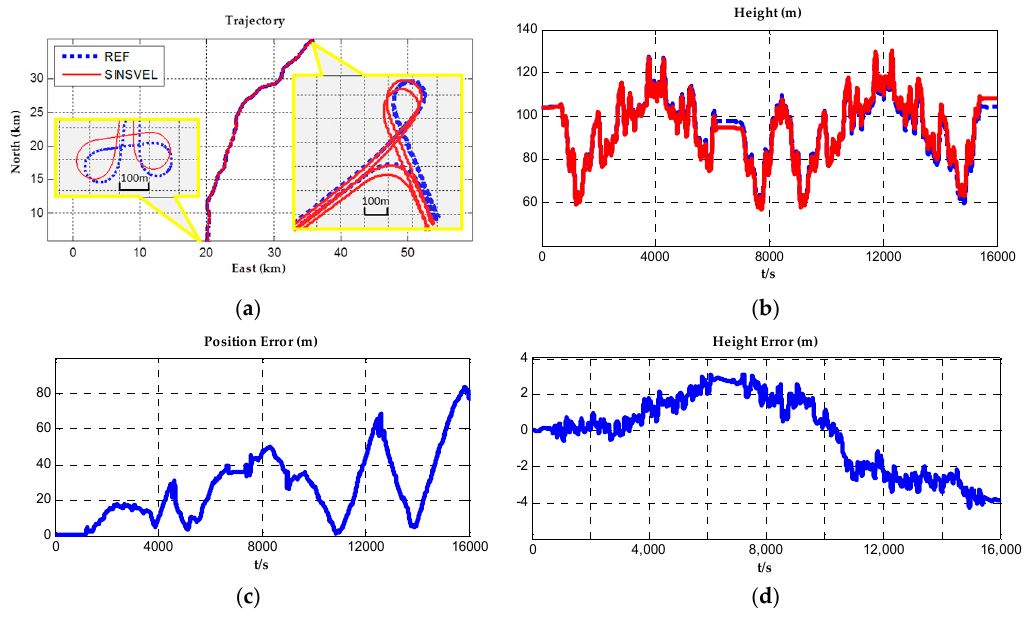
Figure 3. Position and error plots of SINS/VEL computation comparing with the reference data.